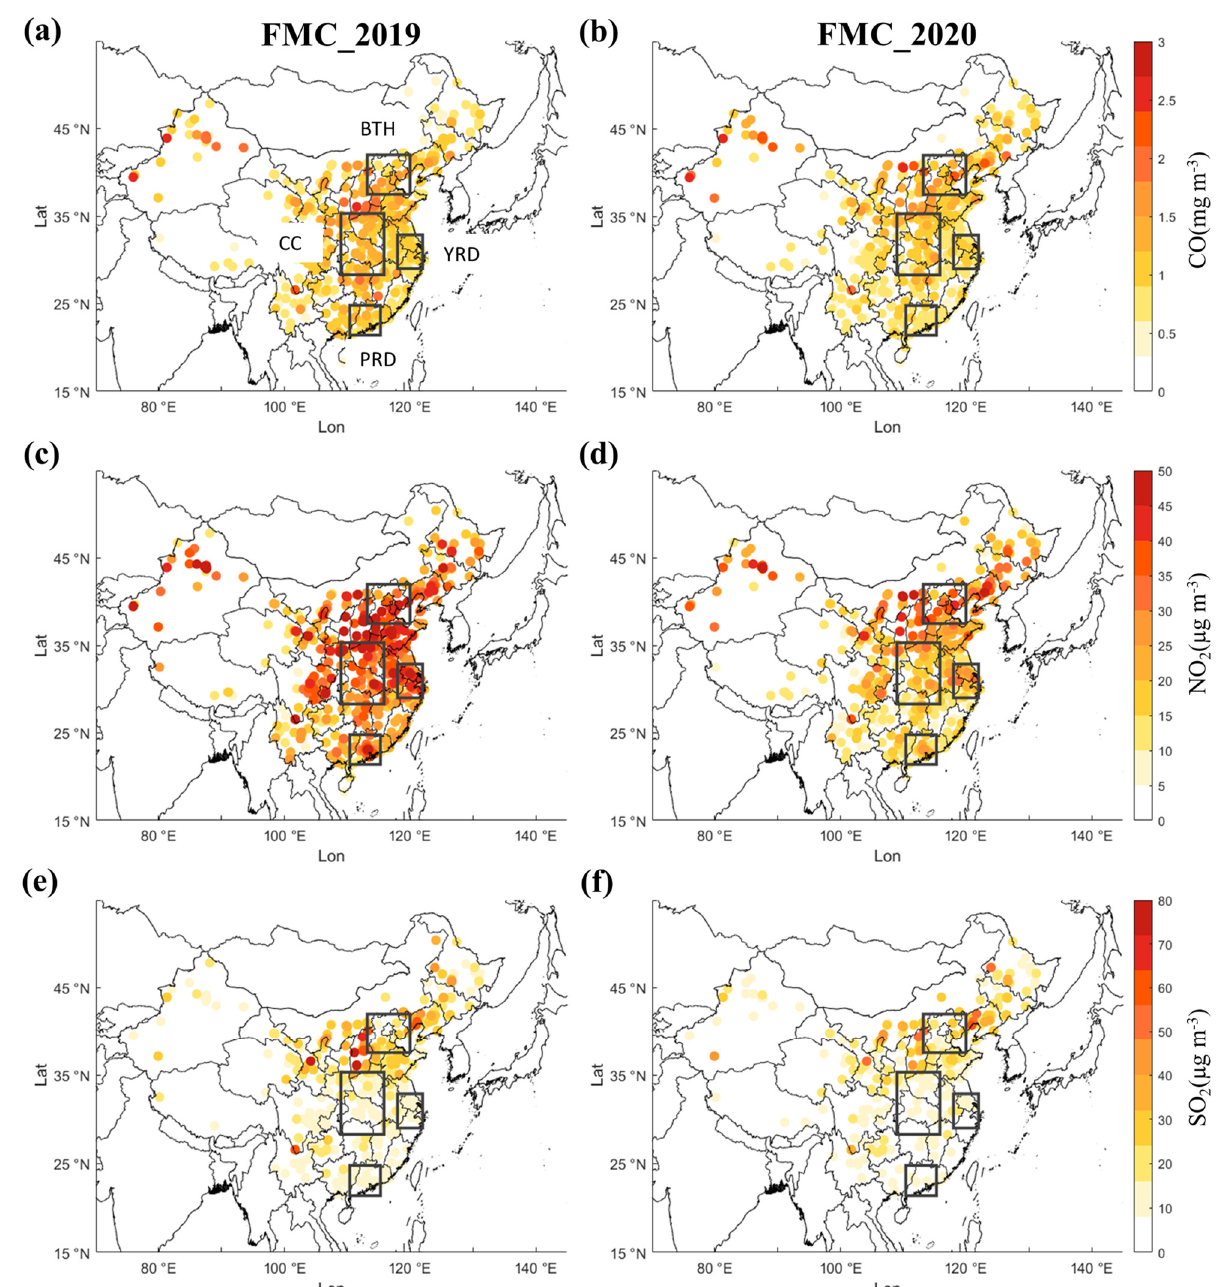
Figure 3. Distributions of monthly average gas pollutants mass concentration (µg m − 3 for NO 2 and SO 2 , and mg m − 3 for CO) in FMC_2019 and FMC_2020 in China. ( a ) and ( b ) CO. ( c ) and ( d ) NO 2 . ( e ) and ( f ) SO 2 . Table 3. Regional monthly average gas pollutants (CO, NO 2 , SO 2 ) mass concentration in FMC_2019